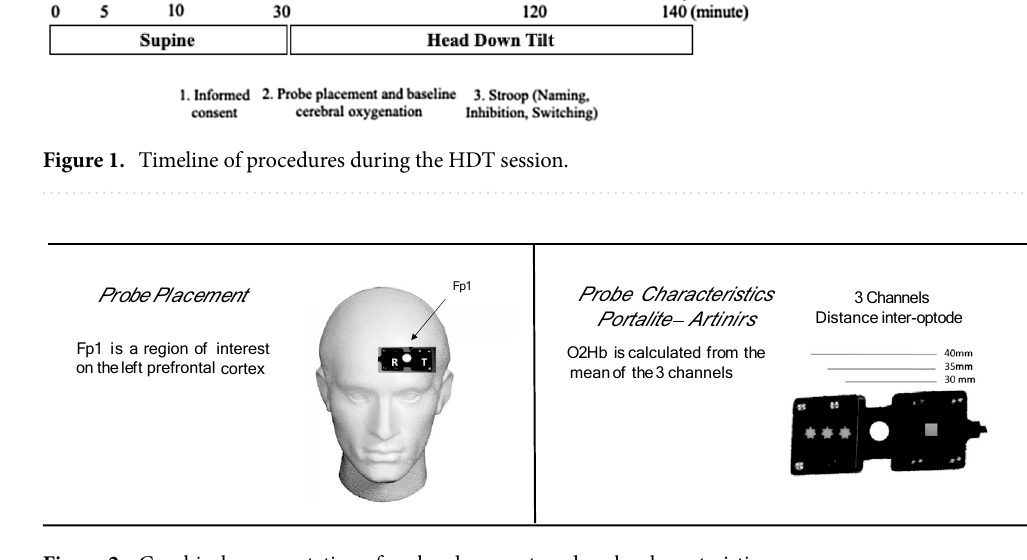
Figure 2. Graphical representation of probe placement, and probe characteristics.